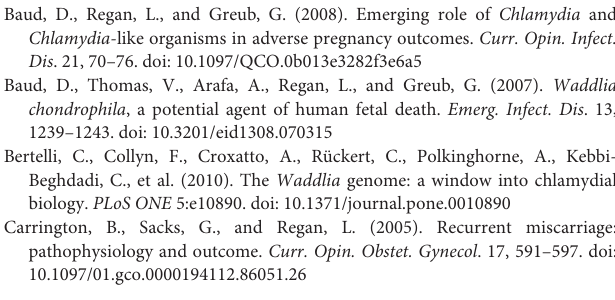
Supplementary Table 2 | Percentage of mice exhibiting splenomegaly, lymphadenopathy, hepatomegaly, severe salpingitis and splenic, hepatic, and uterine horn leukocyte infiltration after W. chondrophila genital